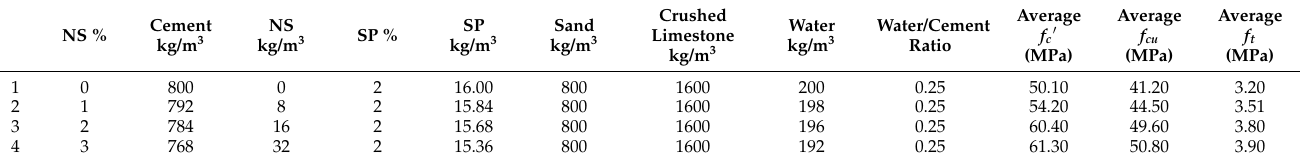
Table 2. Mix proportions.